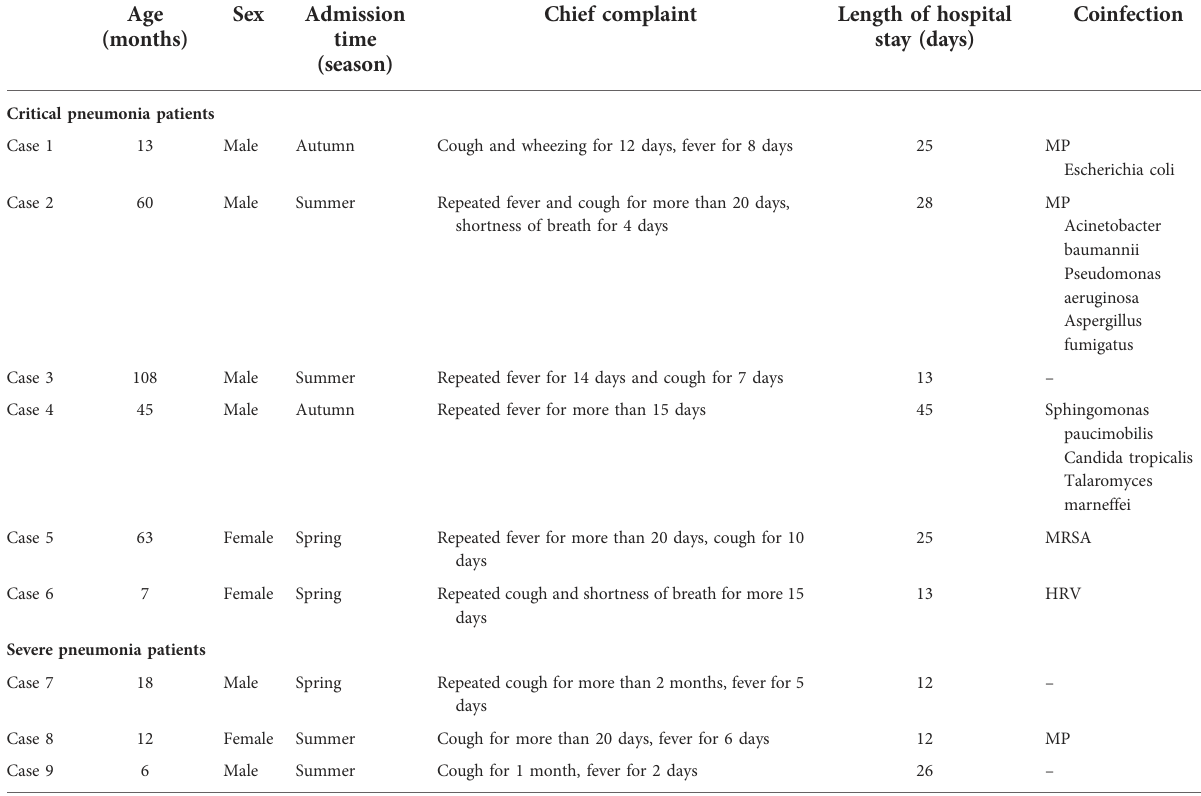
TABLE 1 The clinical characteristics of human adenovirus type 55 infection in severe and critical pediatric pneumonia